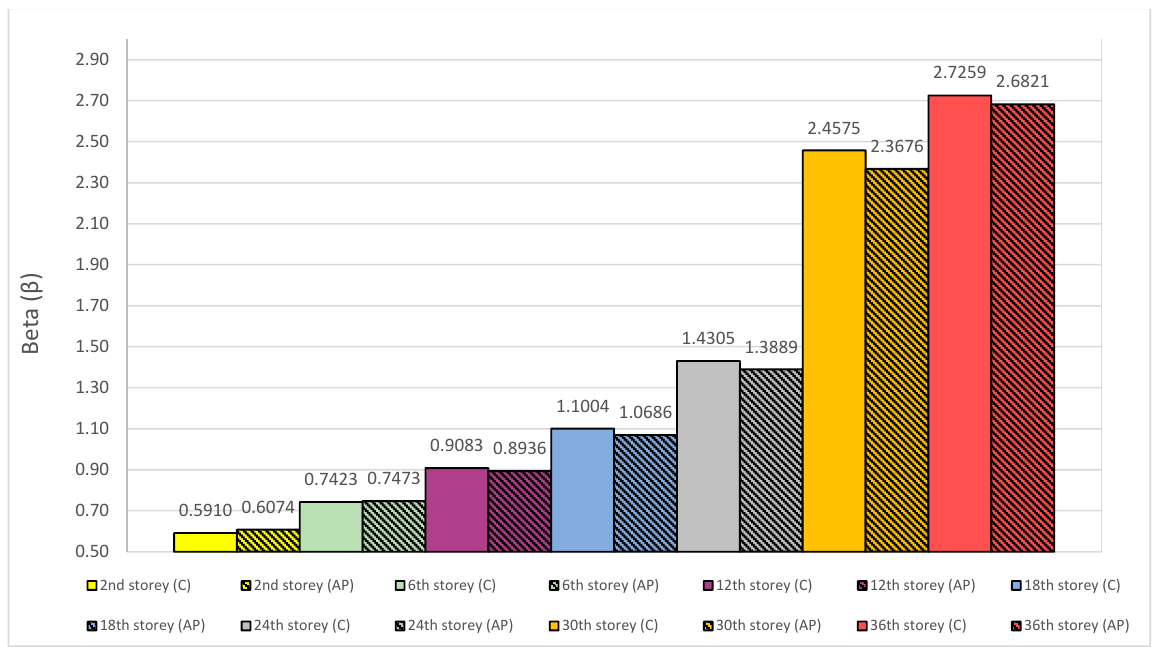
Figure 12. ( a ) The actual wind load profile and ( b ) the constant wind load profile.